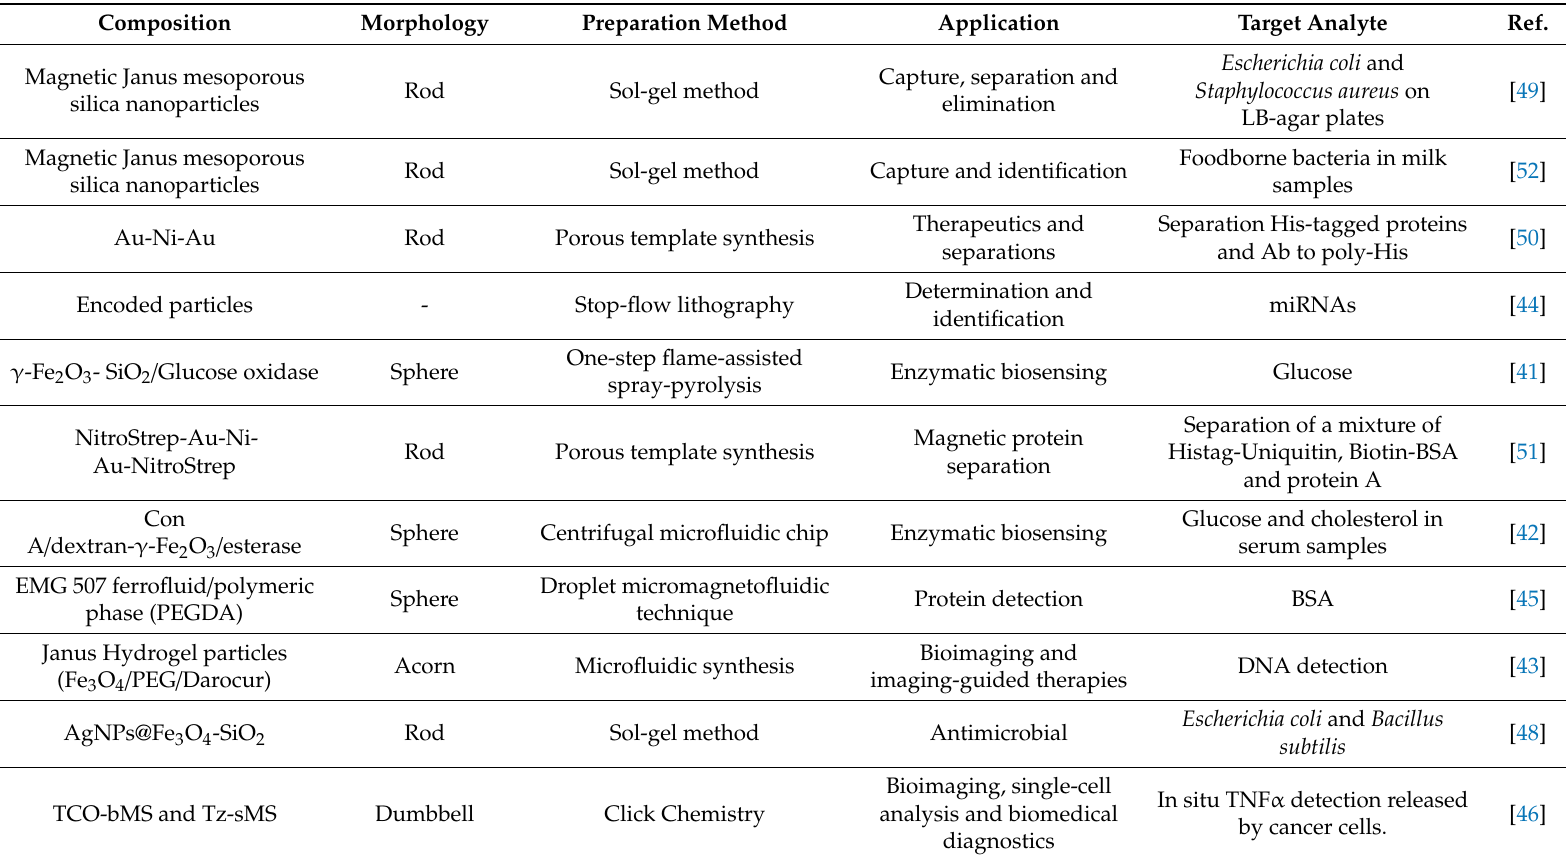
Table 1. Janus magnetic particles for static